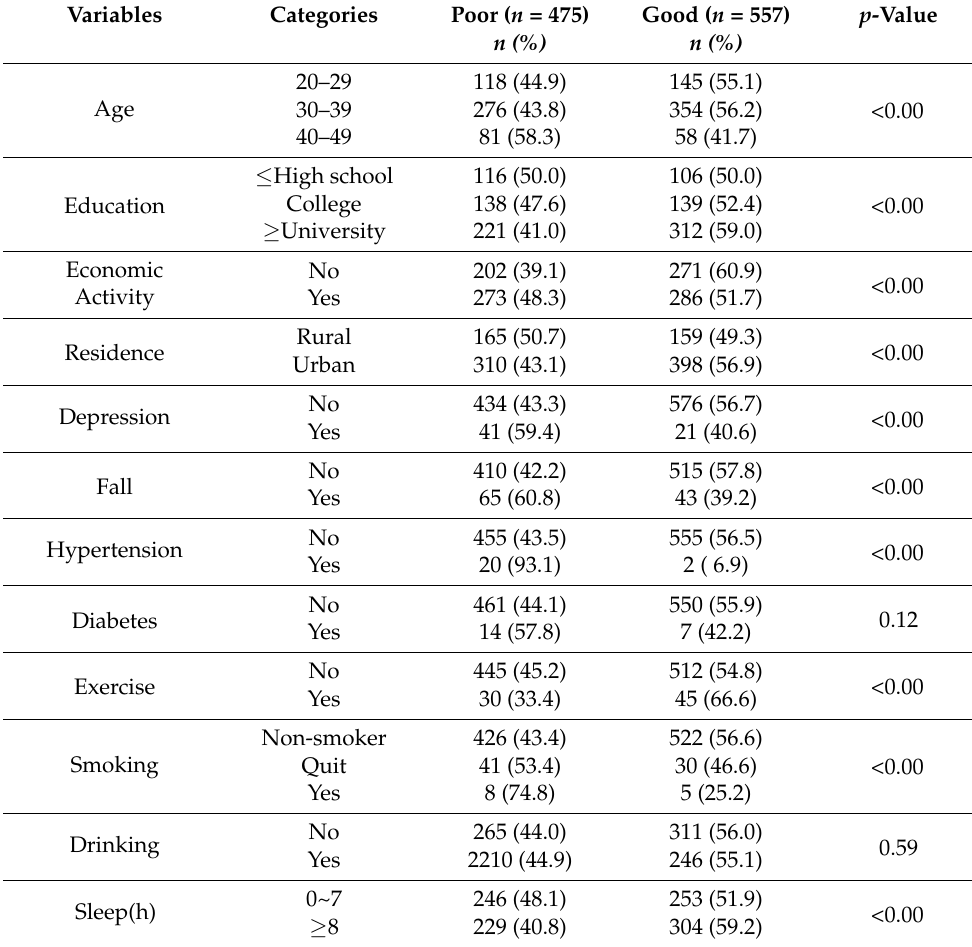
Table 2. Characteristics of the subject according to SRH ( n = 1032).